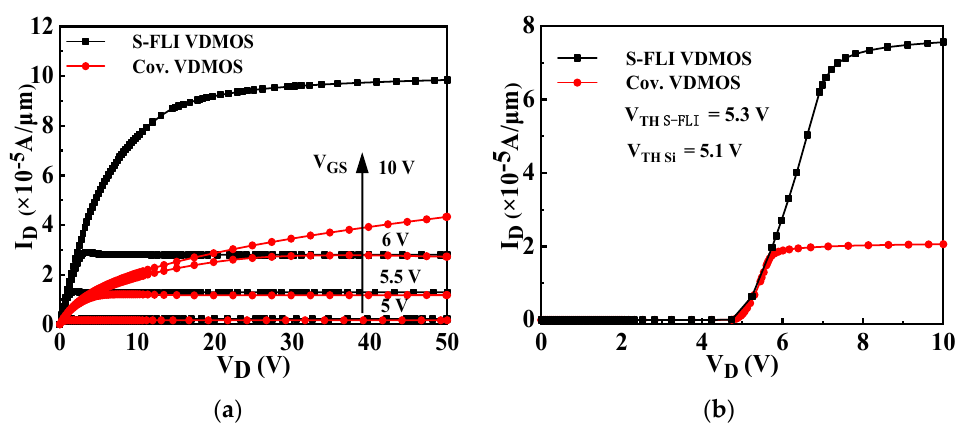
Figure 7. ( a ) Output characteristics and ( b ) transfer characteristics of the conventional Si VDMOS and S-FLI VDMOS.